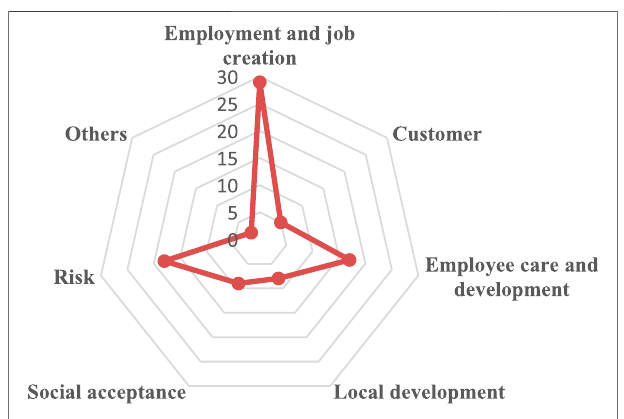
FIGURE 9 | Classi fi cation and frequency of social sustainability